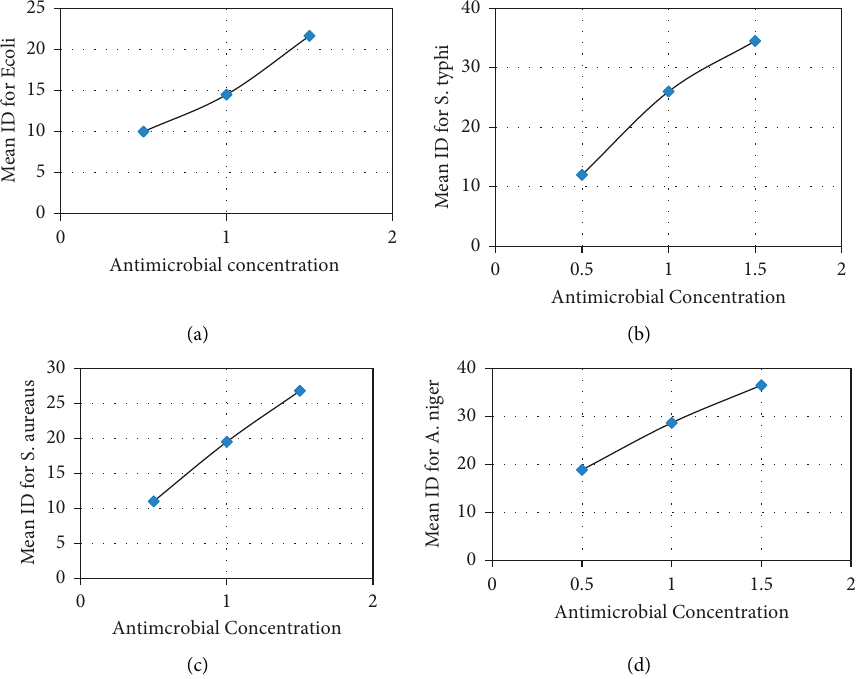
Figure 2: Effect of antimicrobial concentration on inhibition diameter of (a) E . coli ; (b) S . typhi ; (c) S . aureus ; (d) A . niger